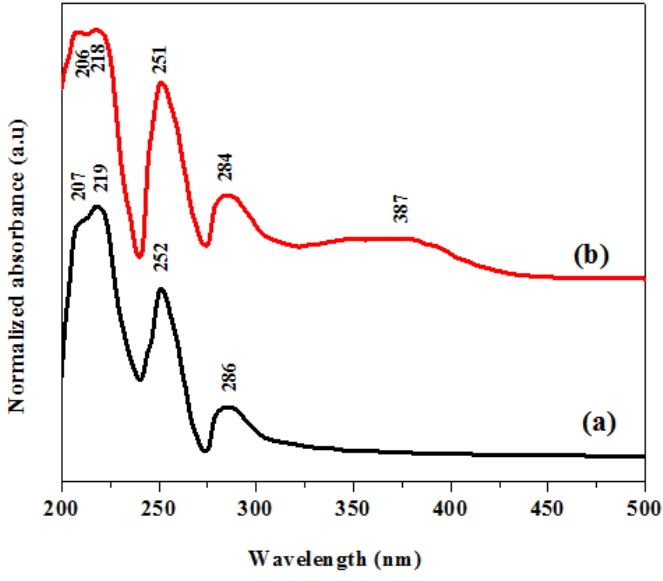
Figure 3. Optical absorption spectra of PANI in the pure ( a ) and doped ( b ) states. Photoluminescence spectra of Figure 4 show that the PANI emits in the spectral range from 340 nm to 480 nm, similar to the previously reported results [46]. The decomposition of PL spectrum shows three lines separated by the same amount of energy (in the order of 215 meV). As this energy corresponds approximately to the most intense band observed on the FTIR spectrum, at approximately 1660 cm − 1 [47], we believe that these lines are derived from 0–0, 0–1 and 0–2 phonon emission. The acid doping is accompanied by a PL quenching effect, indicating that quinoidal fragments are created, representing inter- channel energy dissipation [48]. On the other hand, the spectrum has been red shifted by nearly 14 nm, showing that there is a sufficient decrease in the optical